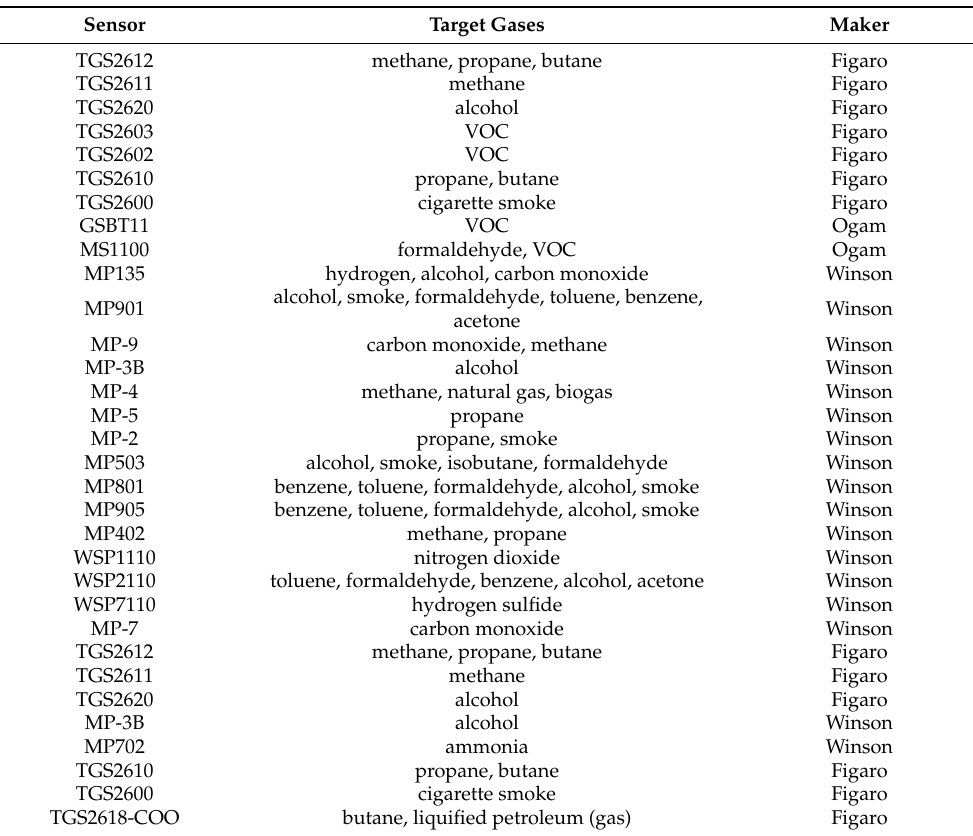
Table 2. Sensors in the sensor